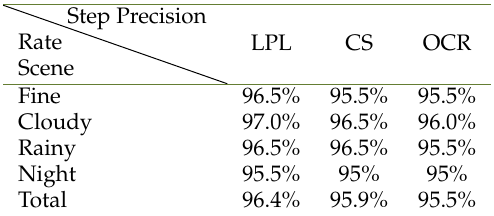
Table 4. Detailed results in different weather Table 5. Accuracy of recognition in different weather